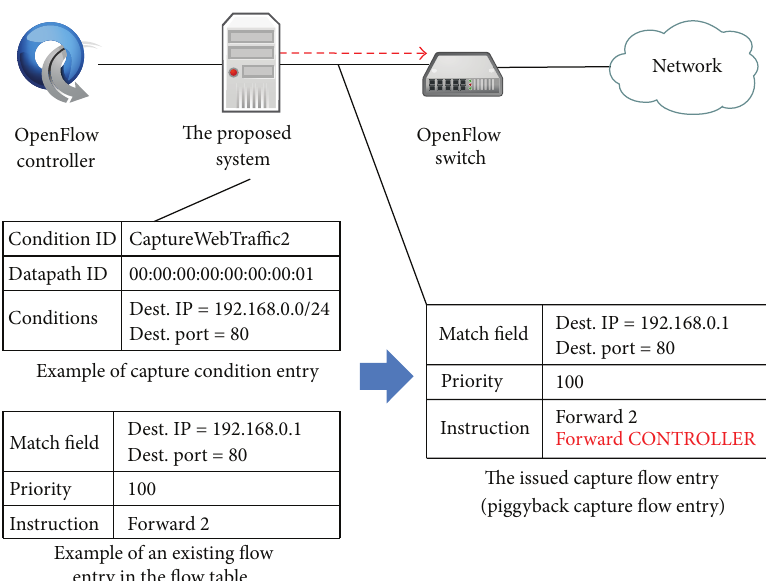
Figure 5: Additional Flow-Mod message for piggyback capture flow entry.